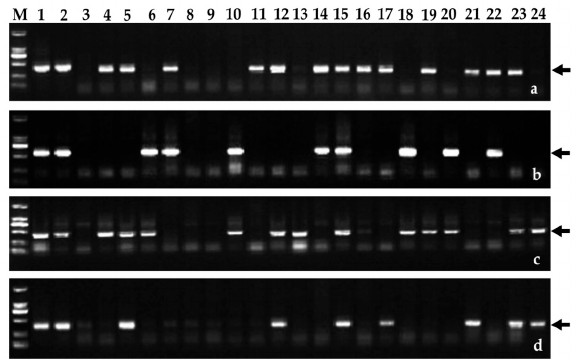
Figure 4. Amplification patterns of the BC 3 F 2 population of wheat- A . cristatum 6P short-arm translocation lines WAT639b using P genome-specific molecular markers, including ( a ) AcPR6; ( b )